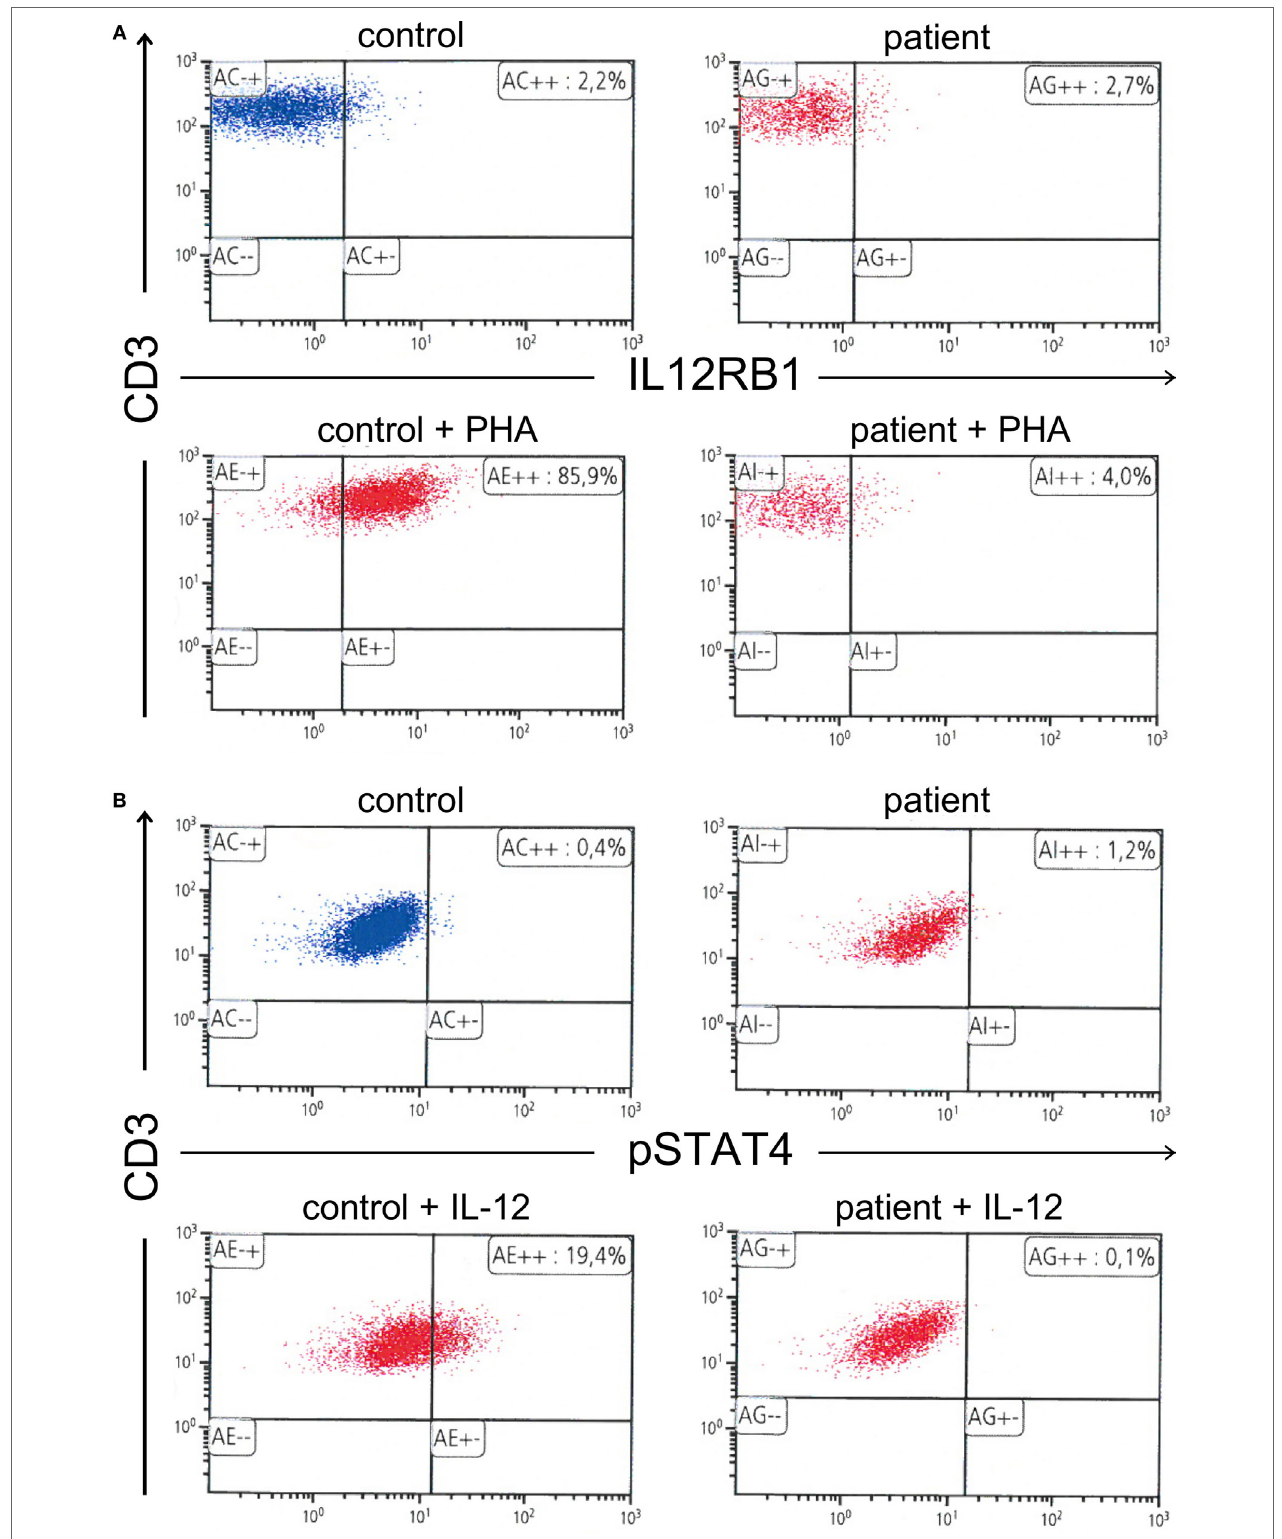
FIgURe 2 | (a) Absence of interleukin 12 receptor beta 1 expression on the surface of phytohemagglutinin-stimulated T cells. (B) Further, absence of signal transducer and activator of transcription 4 phosphorylation in interleukin 12 (IL-12)-stimulated T